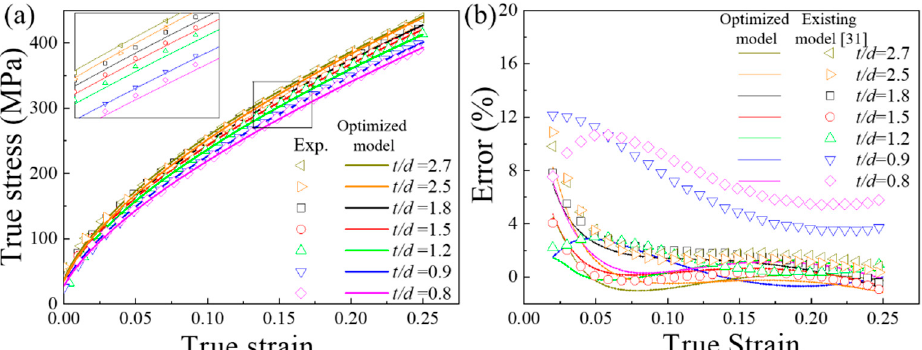
Figure 9. ( a ) Prediction of true stress-strain curves for the optimized constitutive model ( b ) Comparison of error between the optimized constitutive model and the existing constitutive model.